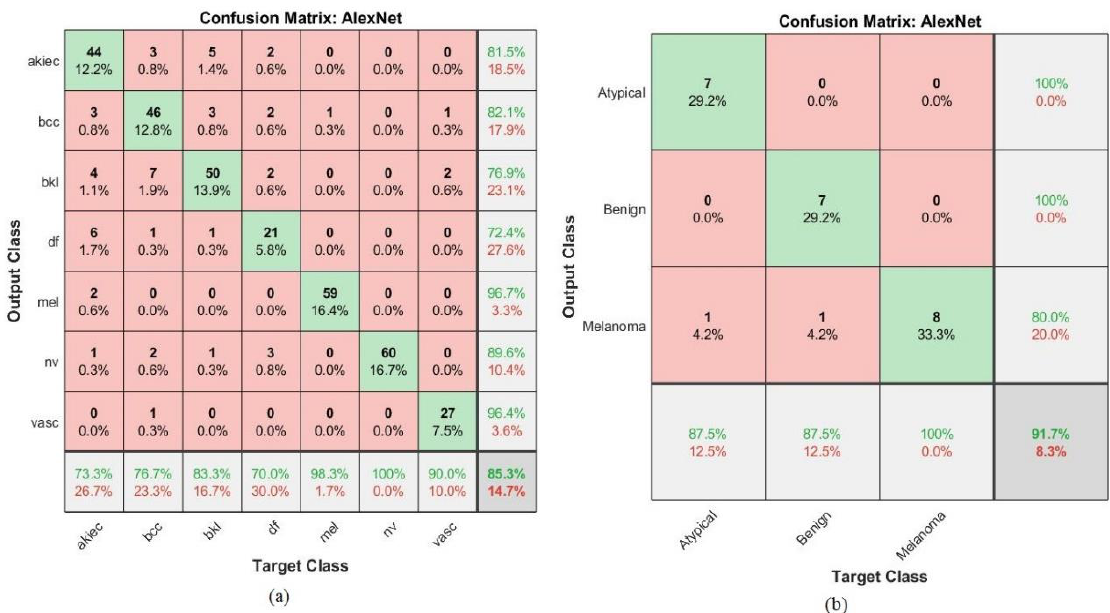
Figure 19. Confusion matrices for the AlexNet model considering the different datasets used. ( a ) The ISIC 2018 dataset. ( b ) The PH2 dataset.